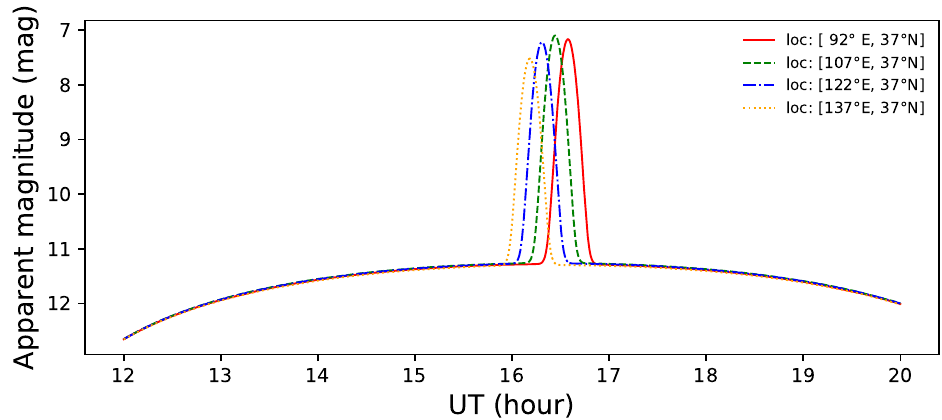
Figure 8. The synthetic light curves simulated with the same model parameters and different station longitudes.